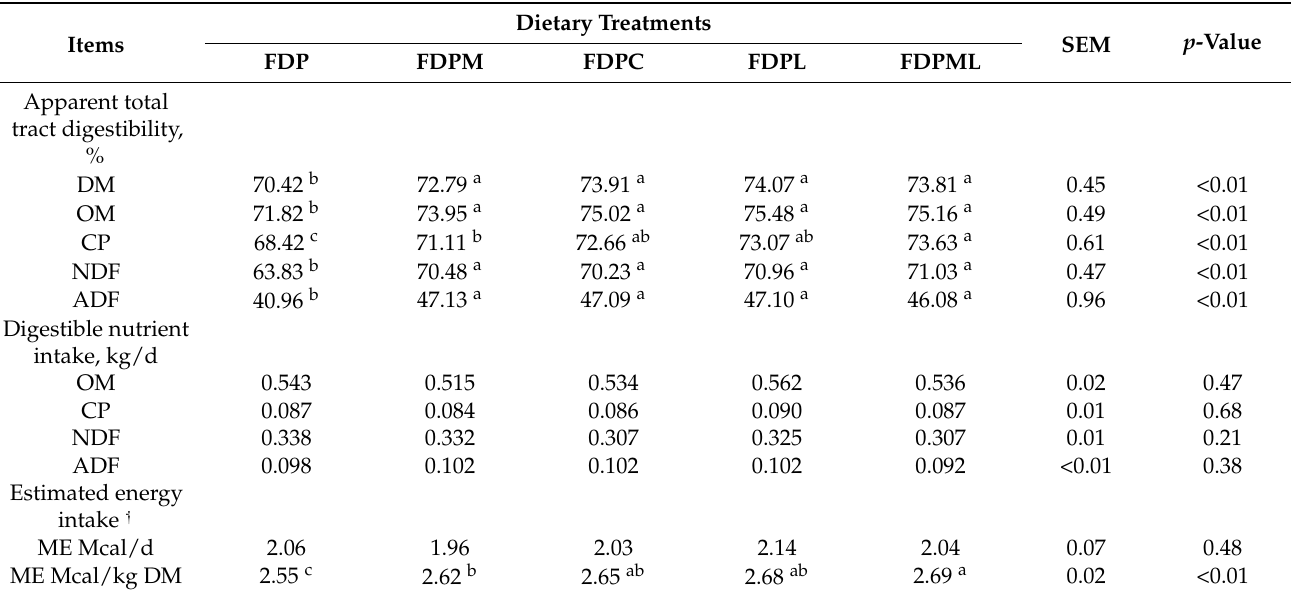
Table 3. Effects of untreated and treated discarded durian peel in TMR on nutrient digestibility and digestible nutrient intake of growing goats.